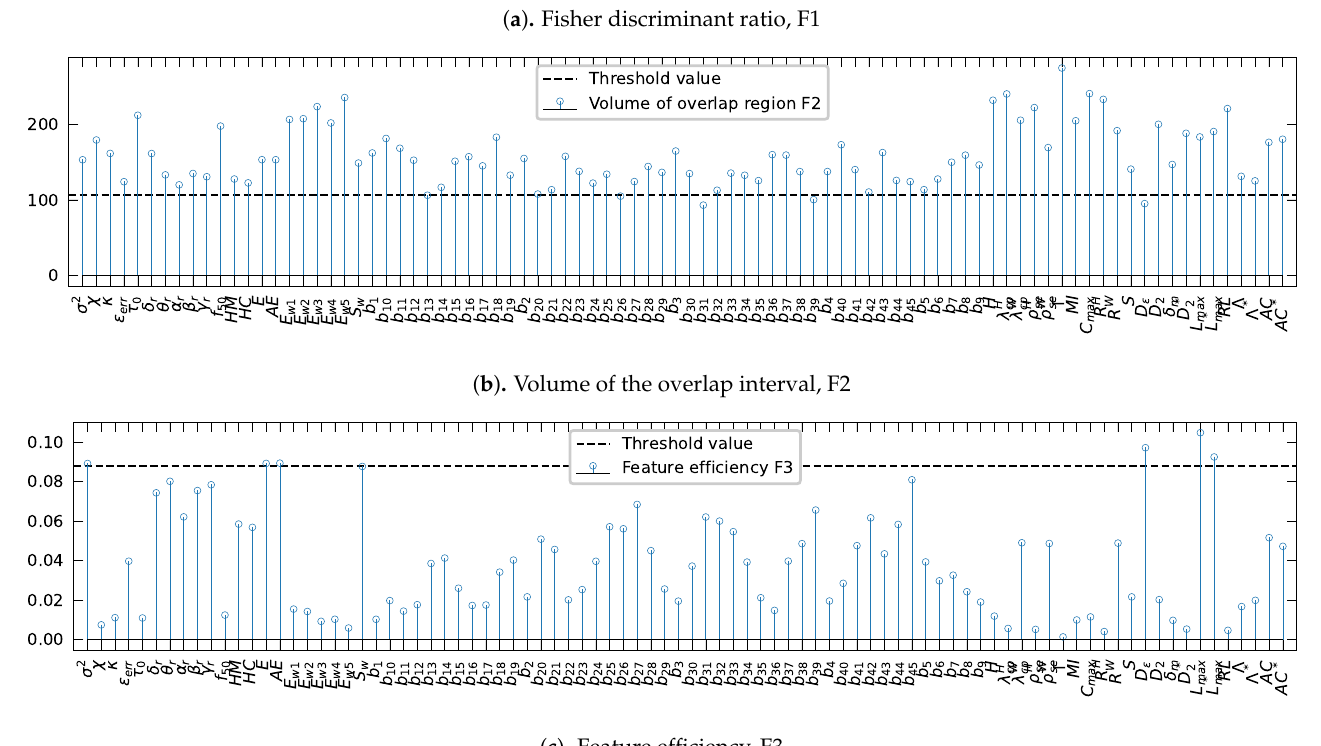
Figure 4. Evaluation of the complexity metrics: ( a ) Fisher discriminant ratio, F1, ( b ) the volume of the overlap interval, F2, and ( c ) the individual feature efficiency, F3. The horizontal dotted blue indicates the threshold values.